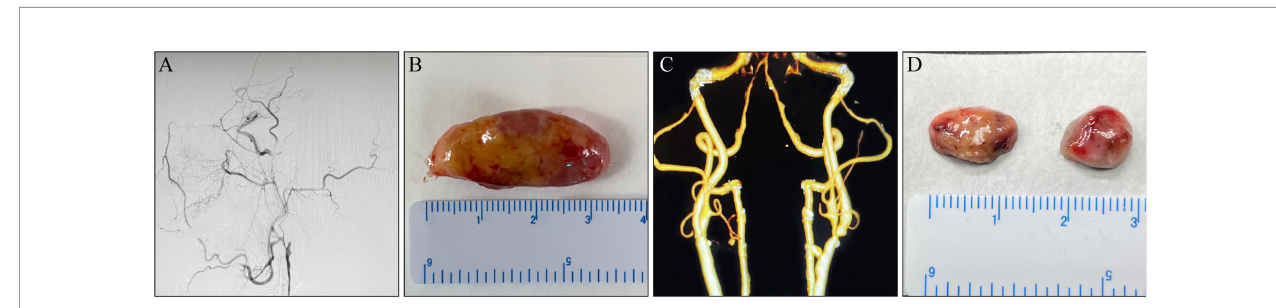
FIGURE 1 | Macroscopic lymph nodes (LNs) morphology. (A, B) A 65-year-old man complaining of alalia for 1 month was hospitalized. (A) Digital subtraction angiogram (DSA) before carotid endarterectomy (CEA) revealed a left internal carotid artery (ICA) with complete occlusion. (B) An enlarged LN around the